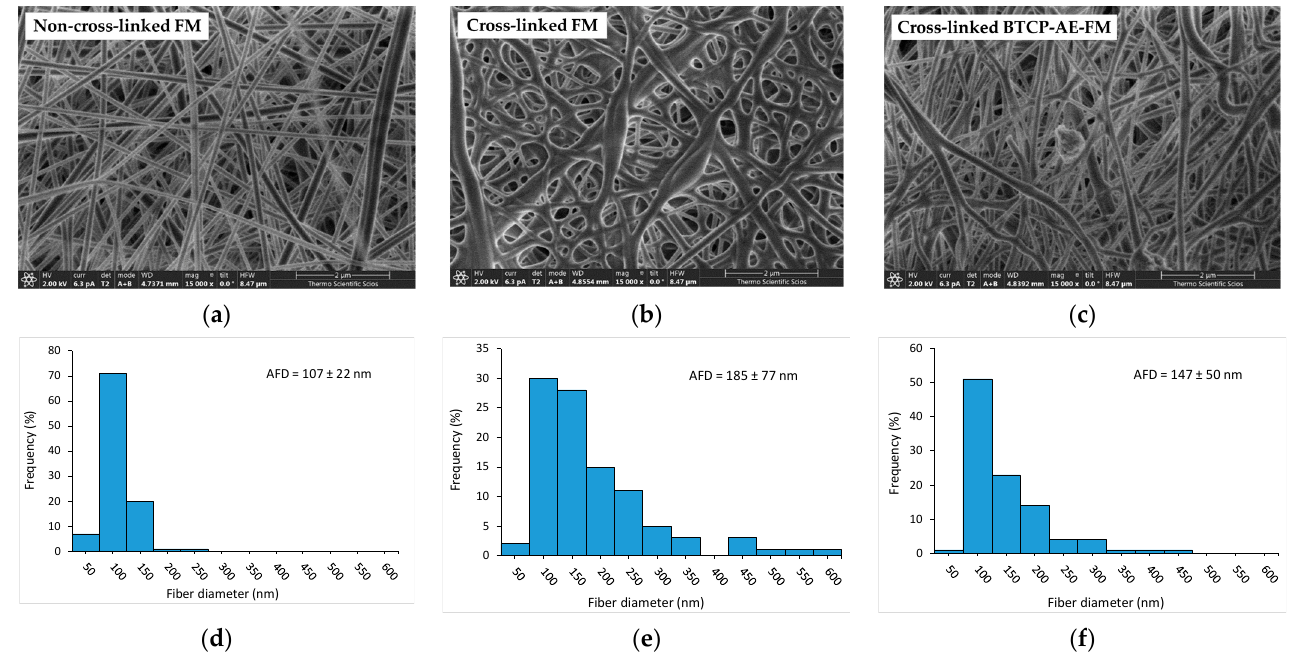
Figure 2. Characterization of the di ff erent types of meshes: ( a ) representative SEM micrographs of a non-cross-linked FM, ( b ) a cross-linked FM, and ( c ) a cross-linked BTCP-AE-FM. Their diameter frequency distributions are shown on ( d – f ) bar graphs, respectively.